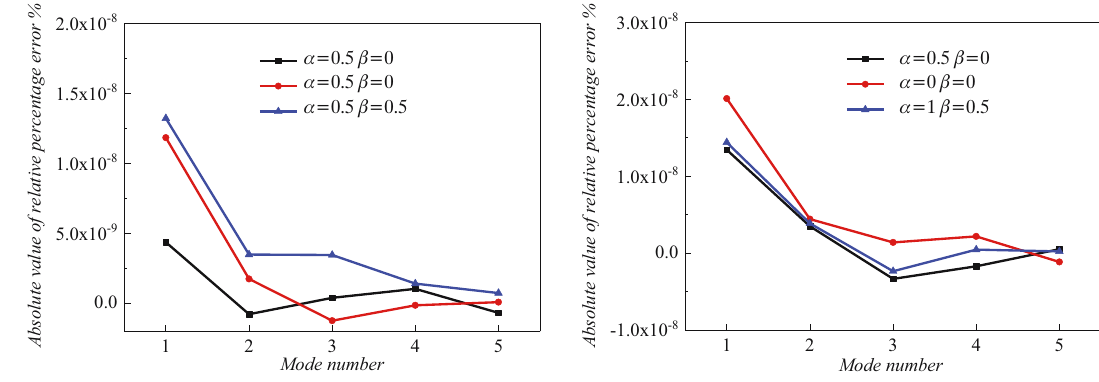
Figure 5: Relative percentage error of rectangular plate with di ff erent Jacobi parameters.